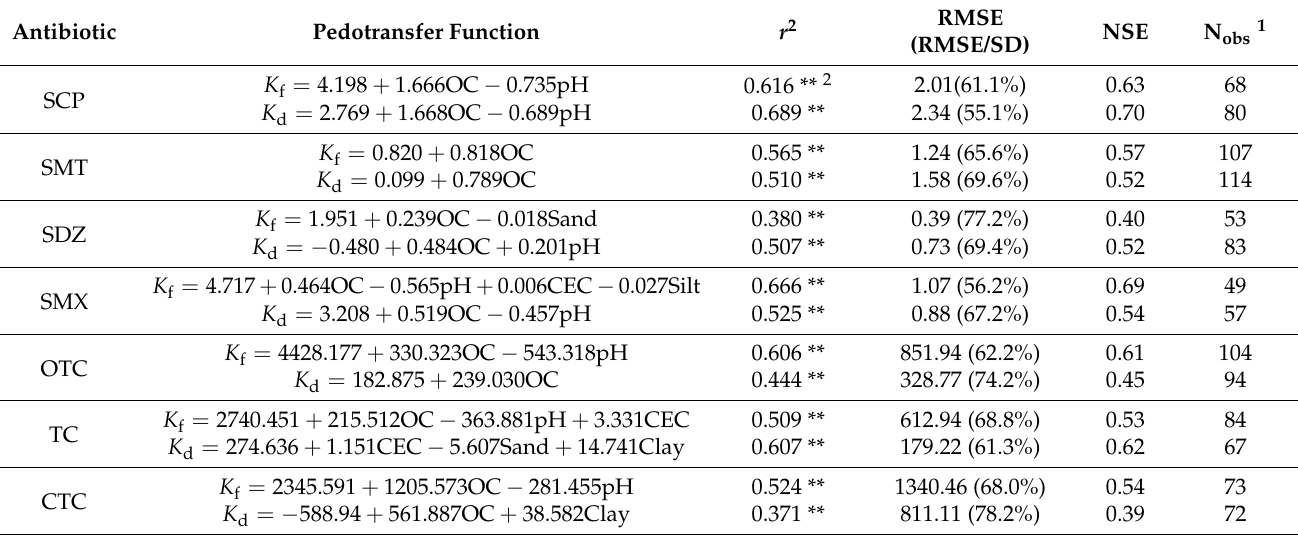
Table 4. Statistical characteristics of sorption parameters of individual antibiotics in the